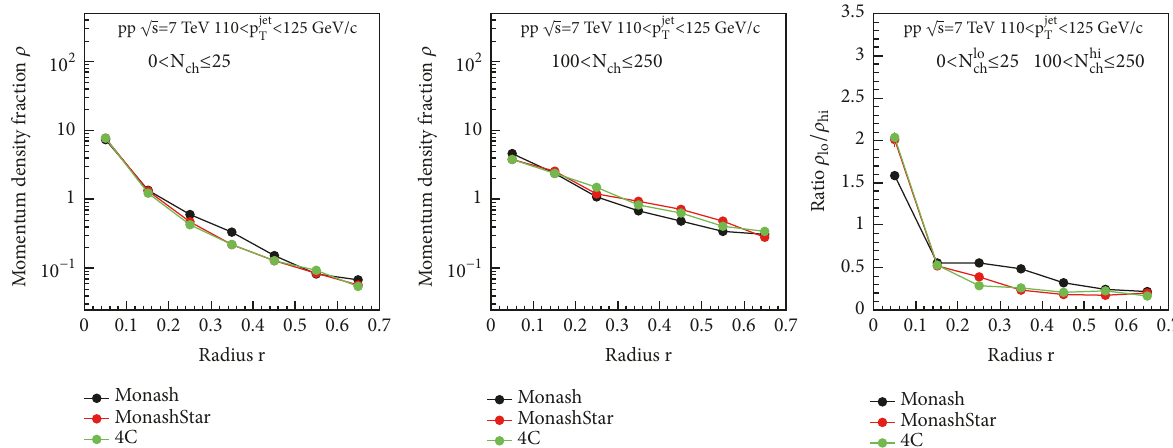
< 125 GeV /𝑐 . Jet 𝜌(𝑟) from events with a T ≤ 250 (center) . The ratio of the ch